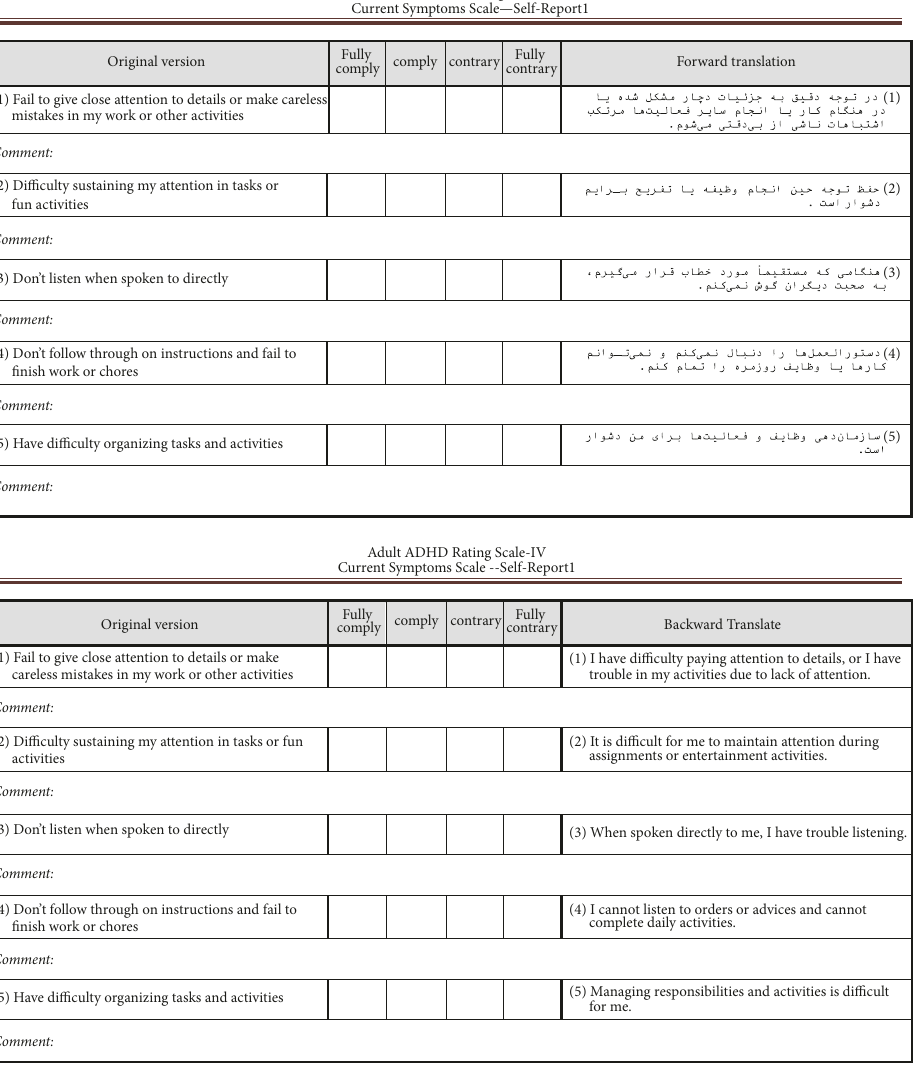
Figure 2: A sample section on the process of accessing compatibility forward and backward translation with the original version.